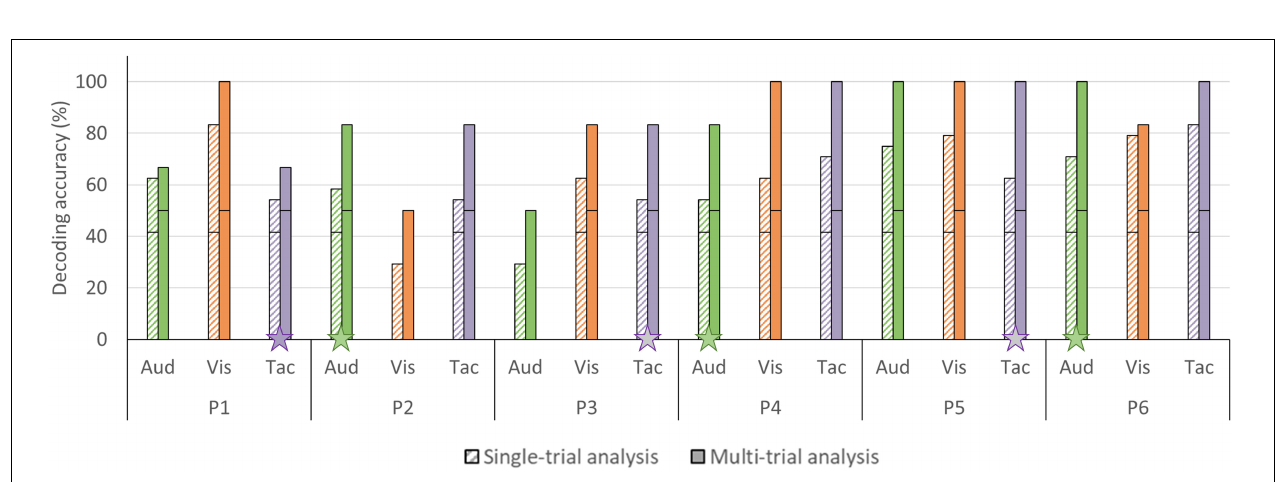
FIGURE 7 | Single- and multi-trial individual decoding accuracies per sensory encoding modality. Individual decoding accuracies for the auditory (green), visual (orange), and tactile (purple) encoding modality obtained with single-trial (striped bars) and multi-trial (solid bars) analysis. The black horizontal stripe within each bar graph represents the chance level for single-trial (41.67%) and multi-trial (50.00%) accuracies. The stars on the horizontal axis mark participants subjectively preferred sensory encoding modality. Abbreviations : Aud, auditory; Vis, visual; and Tac, tactile.